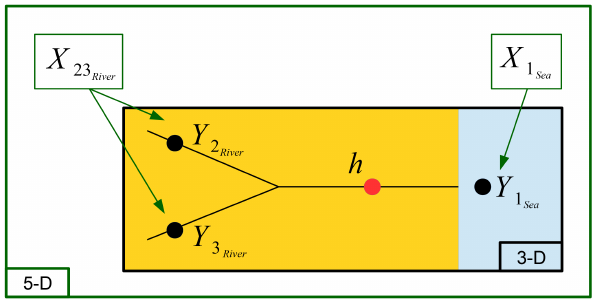
Figure 2. Hydraulic system for the Ravenna catchment. The area af- fected by compound floods is marked by the red point. The impact is the water level h , which is influenced by the contributing variables Y , i.e. sea and river levels. The variables inside the black rectangle are used to develop the three-dimensional (unconditional) model. The X are the meteorological predictors driving the contributing variables Y , which are incorporated into the five-dimensional (con- ditional)